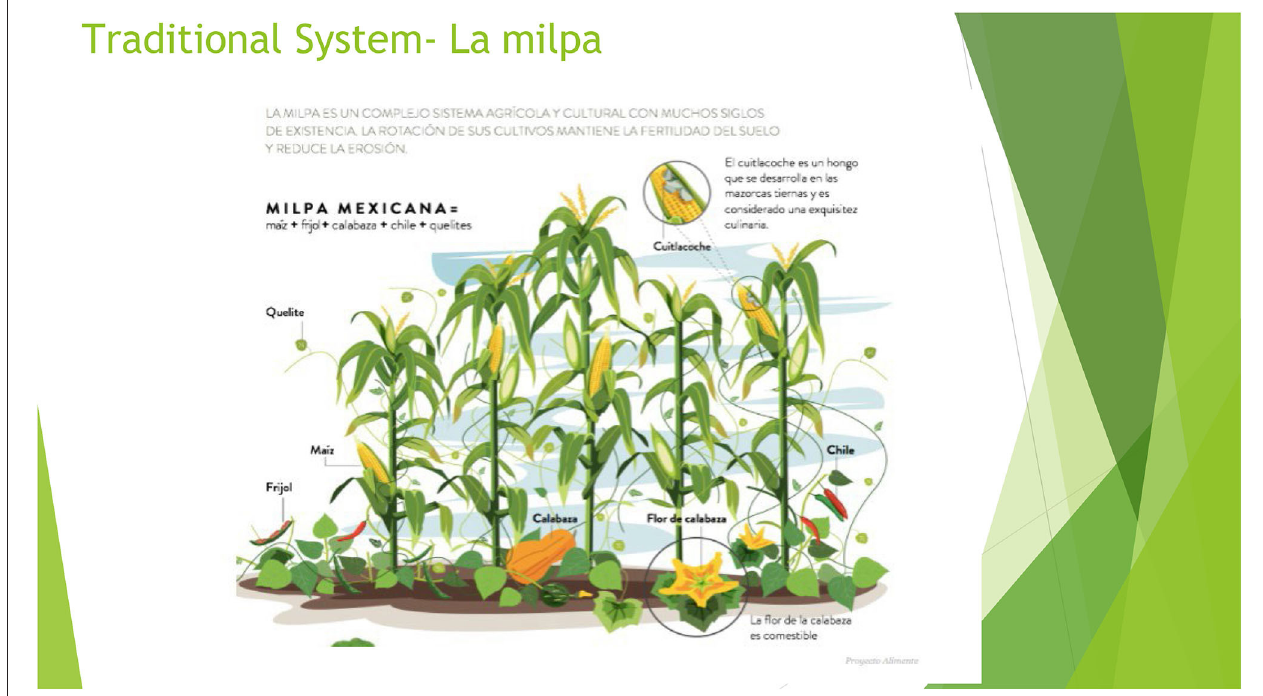
FIGURE 1 | The traditional mesoamerican